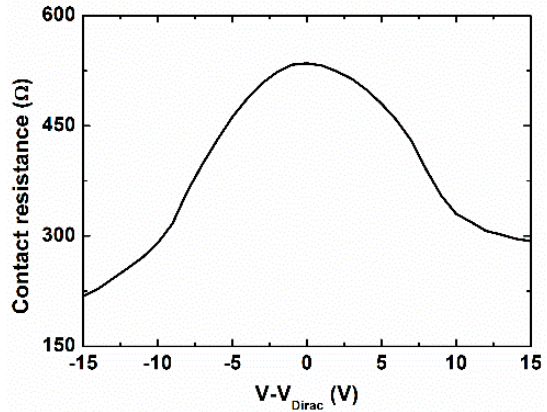
Figure 10. The relationship between contact resistance and bias voltage.